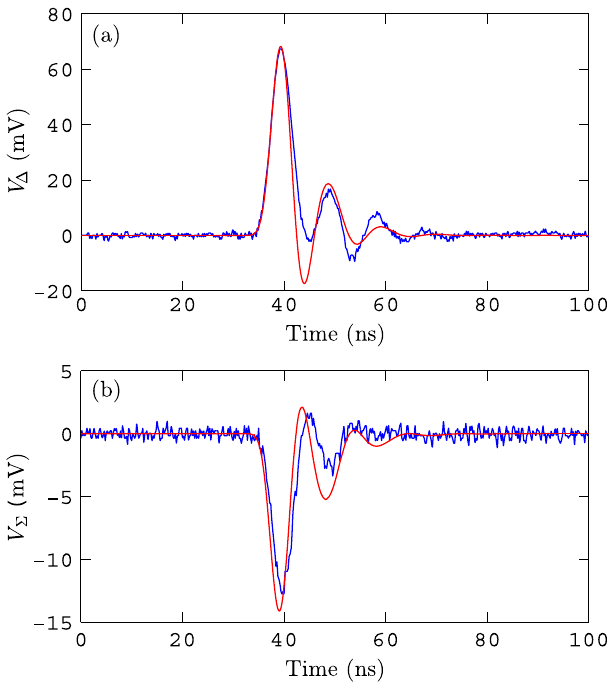
FIG. 9. Recorded (a) V Δ and (b) V Σ waveforms from the processor (blue) compared with the model (red).